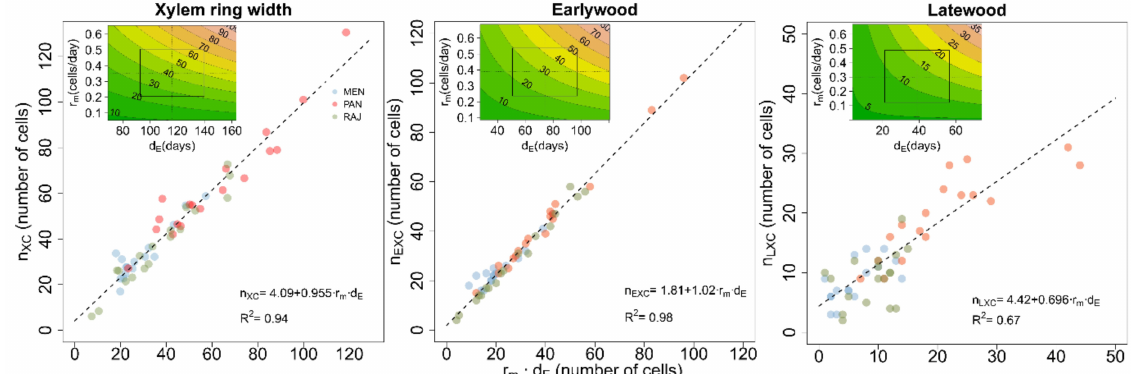
Figure 2. Simple physical model of the total number of xylem cells ( n XC ), number of earlywood cells ( n EXC ), number of latewood cells ( n LXC ), and the average rate ( r m ) and duration ( d E ) of production of these cell types in Norway spruce. The dashed line represents the regression. Sensitivity analysis of the physical model for the widths of xylem ring, earlywood, and latewood. The dashed lines represent the means, and the frame delimits the area of the mean ± standard deviation. Table 4. Results of sensitivity analysis for the widths of xylem ring, earlywood and latewood